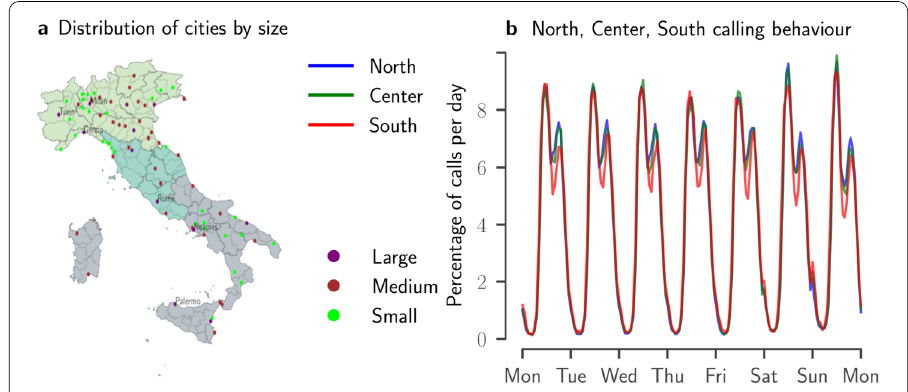
Figure 1 ( a ) The 76 selected cities, their geographical position in Italy, and their size according to the OECD categorization. ( b ) Average volume of outgoing calls as a percentage by hour for the cities in the North, Center and South of Italy. We can see that during weekdays the drops in percentage of calls for South of Italy cities are delayed compared to the behavior of the ones from the North and the